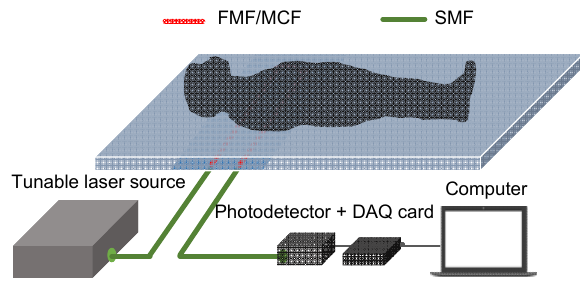
Fig. 9 | Vital signs monitoring experimental setup, including the in-line optical fiber interferometers based on FMF and MCF, which are placed under the mattress, a TLS for wavelength tuning and a photodetector as well as a DAQ card for data